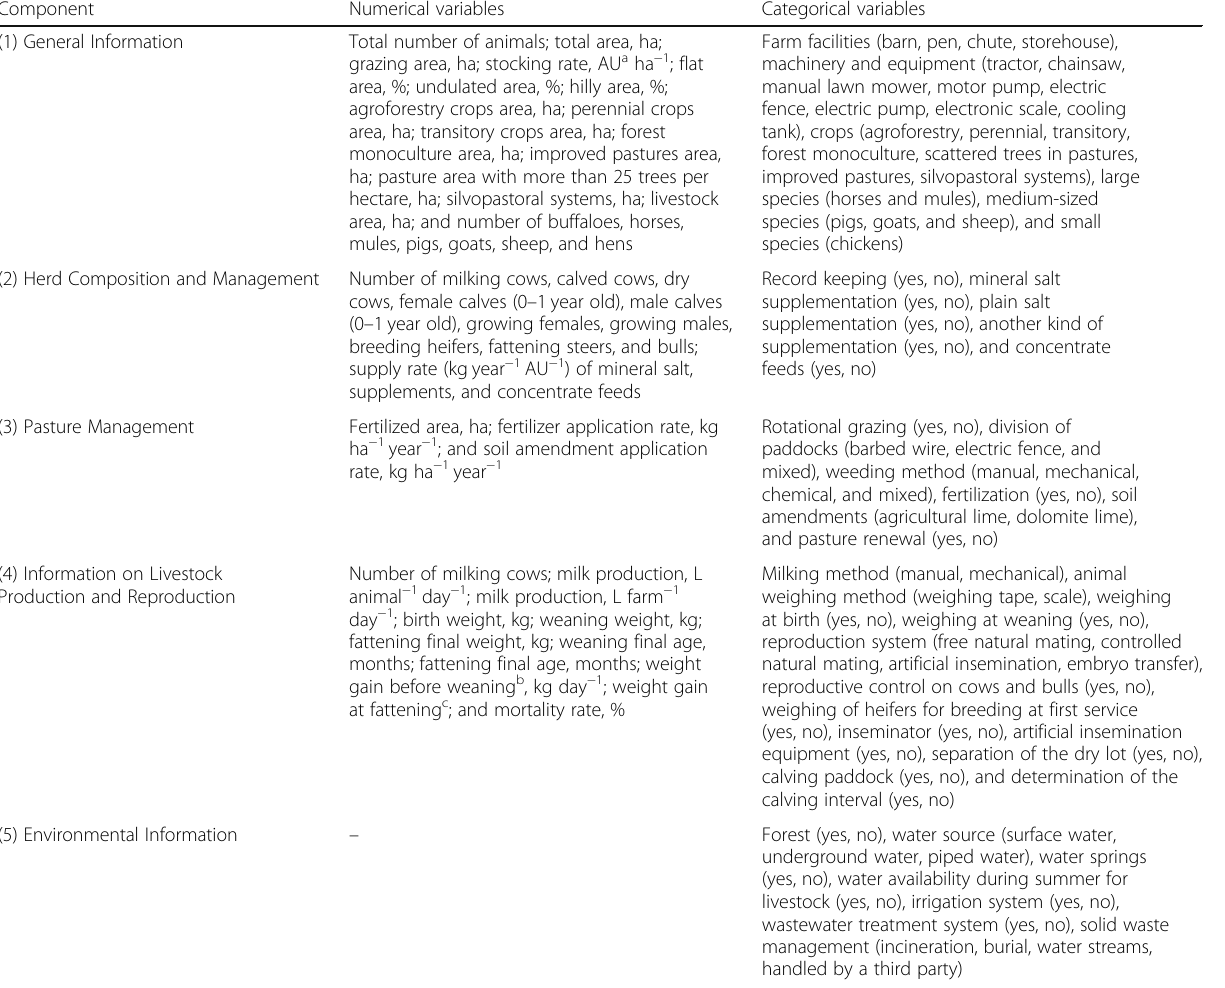
Table 1 Components and variables used for the characterization of dual-purpose farms